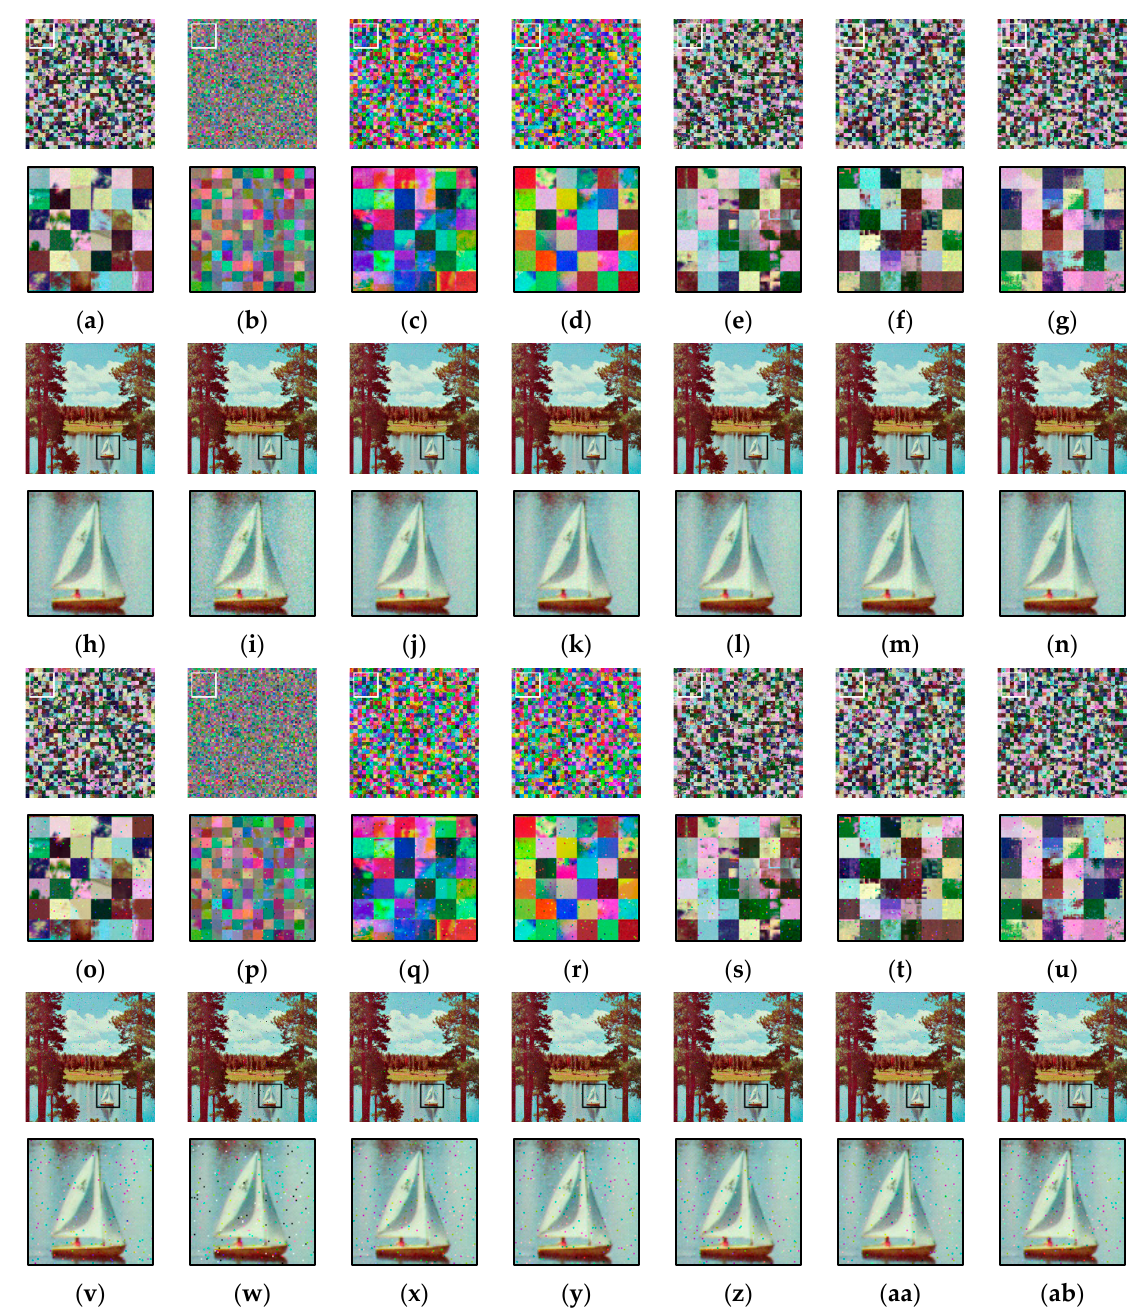
Figure 22. The CPE methods robustness against the noise attack. ( a – g ) and ( o – u ) are the cipher images given in Figure 20 b – h with the noise attack by adding Gaussian and Salt–Pepper noises, respectively. The recovered images for ( a – g ) are shown in ( h – n ), and for ( o – u ) the recovered images are in ( v – ab ). For better visual inspection, the boxed region in each image is enlarged and shown below them. Table 9. Quality of the recovered images under the di ff erent types of loss a tt acks shown in Figures 21 and 22.